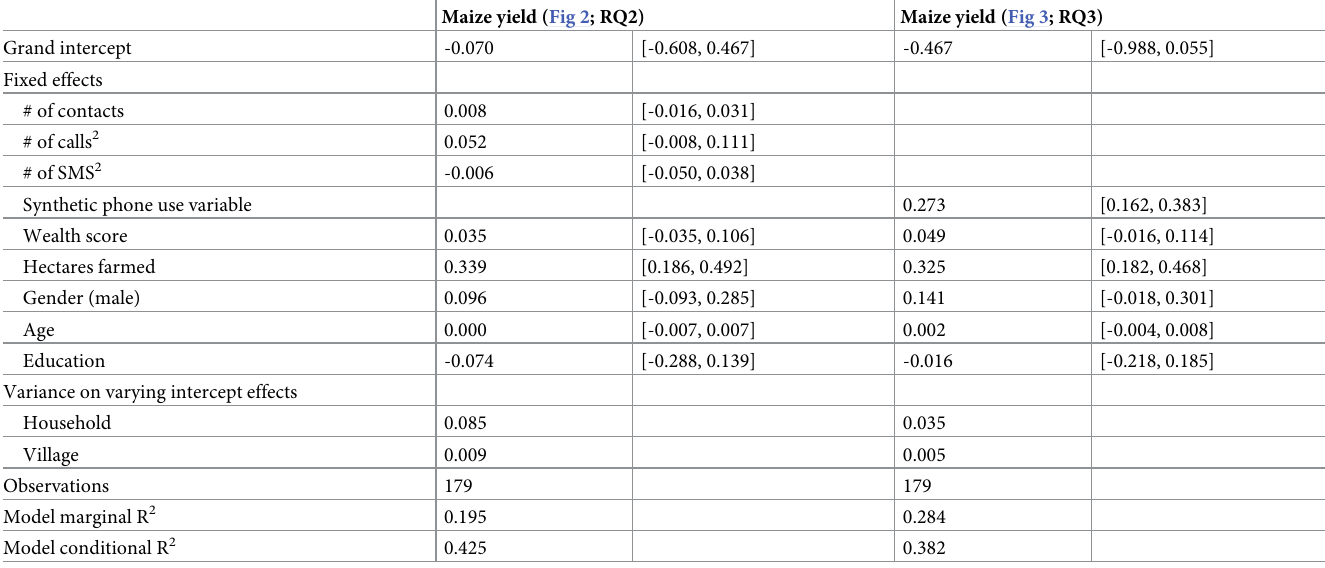
Table 4. Model estimates and [95% confidence intervals 1 ] for Figs 2 and